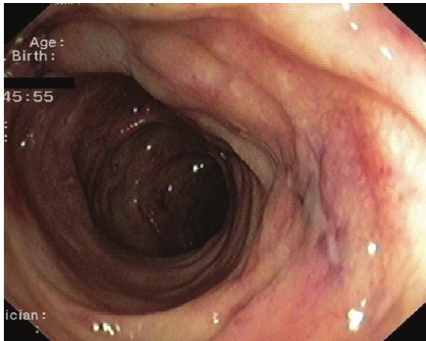
Figure 1: Edema and shallow ulcers in the sigmoid colon. Histology revealed atypical cells with CMV inclusion bodies.